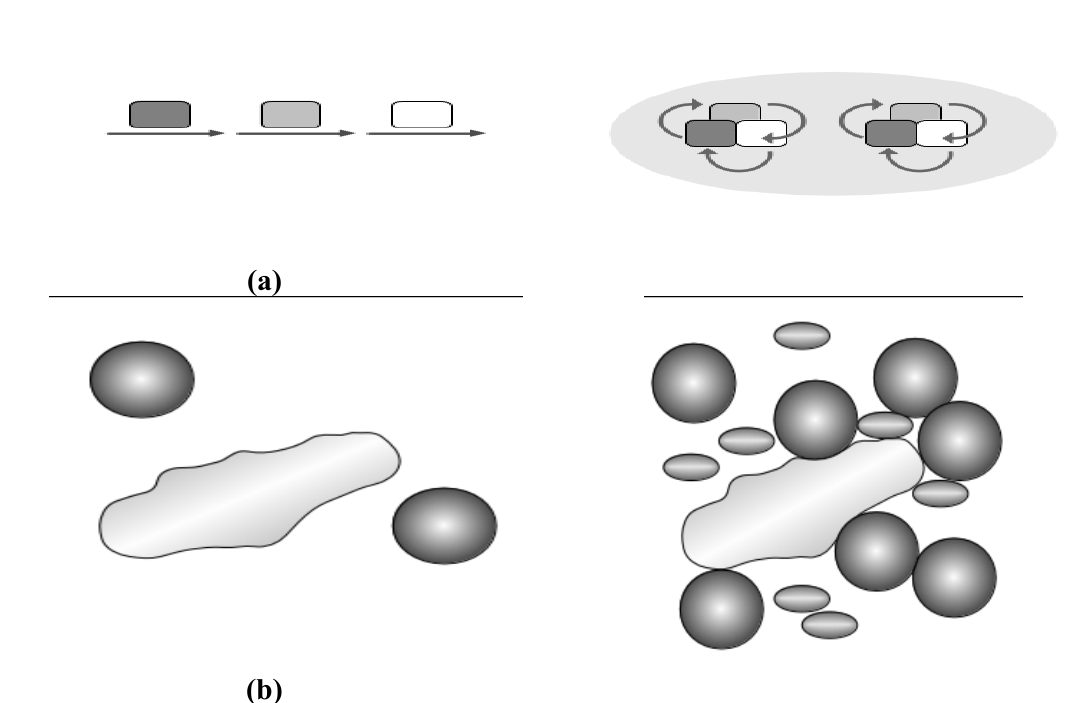
Figure 3. ( a ) Substrate channeling. Originally a conveyor belt concept was invoked (left): Substrate (arrows) is passed from one enzyme to the next (squares in different grey shades). A more modern view (right) considers complexes central for channeling and places the protein complex in the middle, substrates change and are passed around (arrows), furthermore, super-complexes (grey ellipsoid in the background) unite different complexes for even more efficient channeling; ( b ) Molecular crowding. A large molecule (long shape, left) cannot freely move if some obstacles are present (proteins shown as spheres). The effect becomes more pronounced (right) with diverse and more protein species present (different spheres and